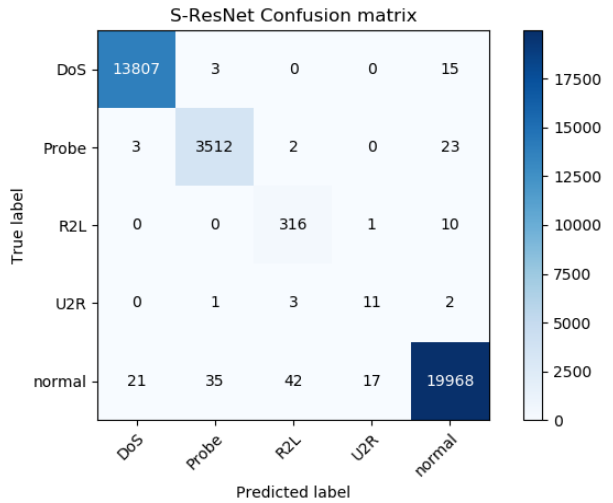
Figure 8. The S-ResNet used in the experiment.